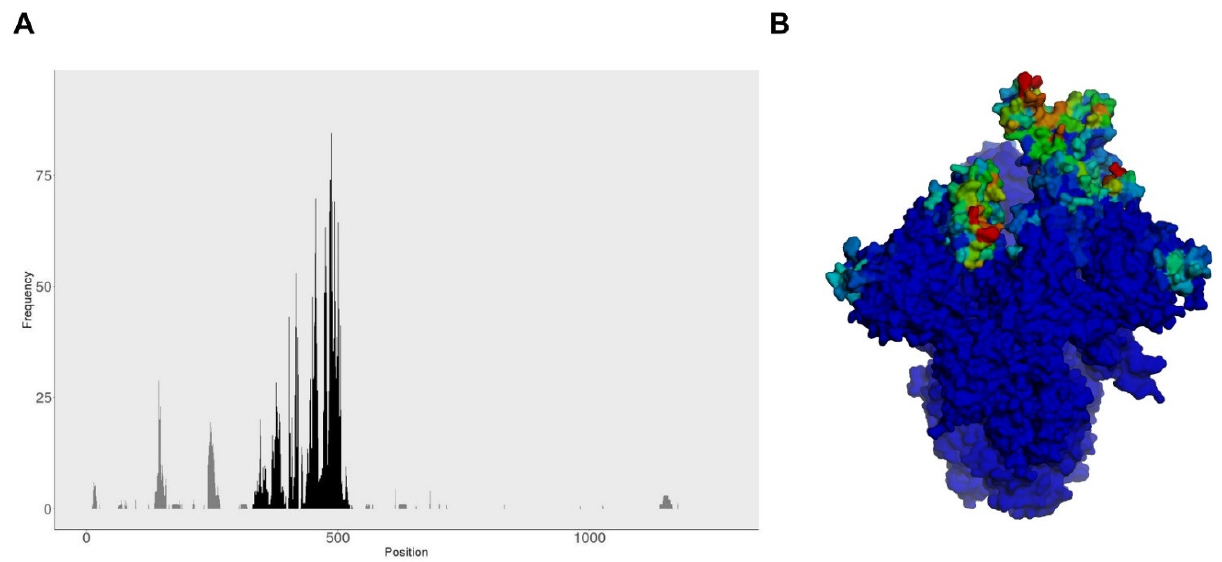
Figure 2. Spike residues targeted by neutralizing antibodies. ( A ) Plot depicting the occur- rence/frequency of SARS-CoV-2 spike residues (X-axis) in distinct B cell epitopes targeted by neutralizing antibodies (Y-axis). The receptor-binding domain (RBD) is highlighted in black; ( B ) Molecular surface of SARS-CoV-2 spike protein with residue recognition frequency by neutralizing antibodies shown in a color gradient from dark blue (not recognized) to green and then to bright red (most frequently recognized). Rendering was generated with PyMOL upon a PDB of the 3D-structure of SARS-CoV-2 spike protein with the occurrence of residues in B cell epitopes assigned to B-factors.